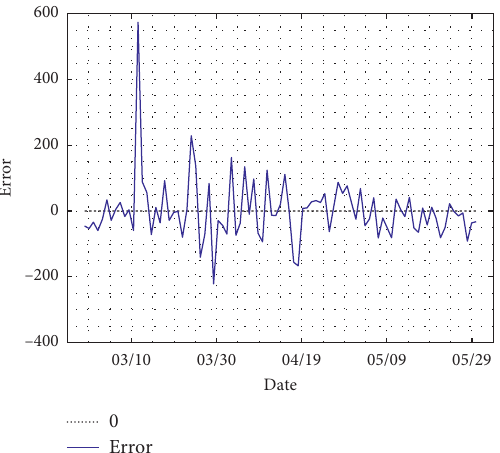
Figure 6: The fitting error of Germany with a mean absolute error of